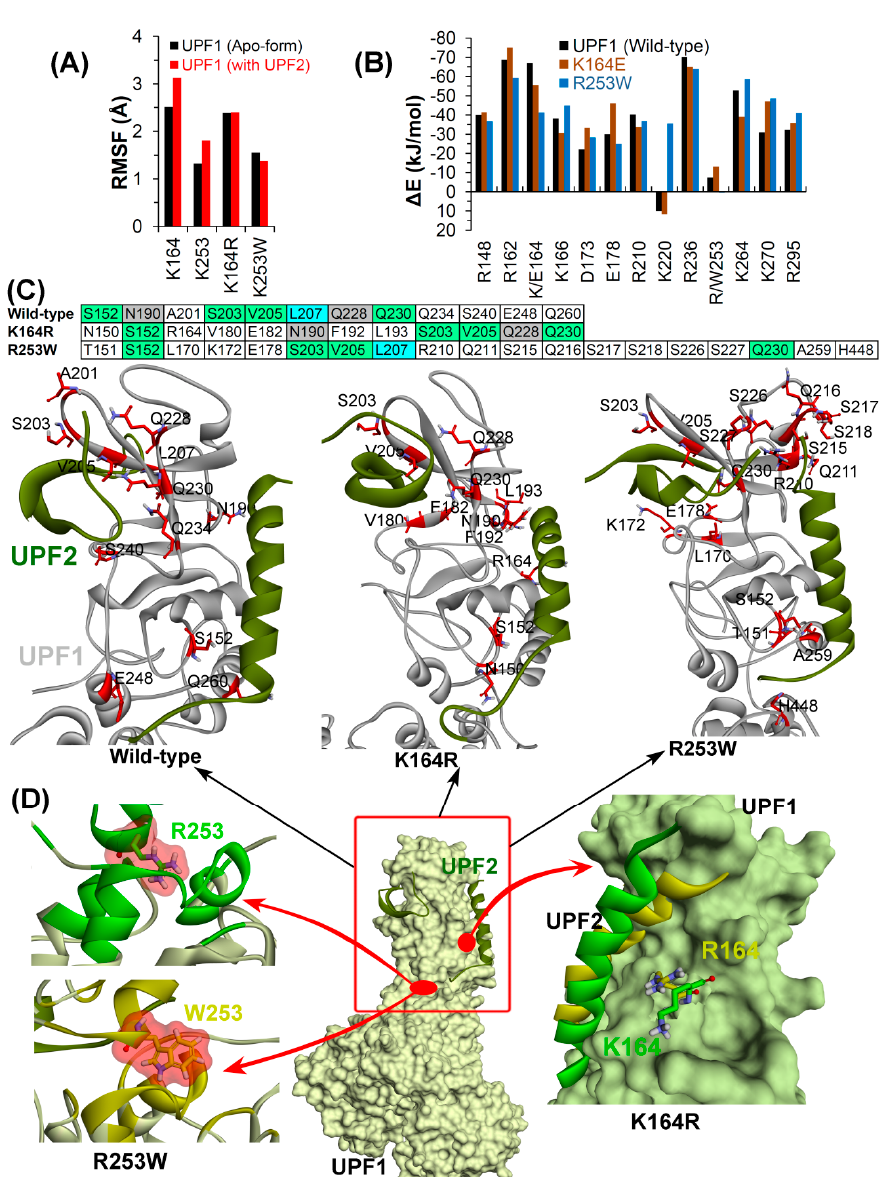
Figure 7. Detailed analysis of UPF1-UPF2 model systems. ( A ) UPF1 residues involved in binding with UPF2 and their mutations. RMSF values were calculated in native or wild-type UPF1, mutant models, apo-form, and UPF1 bound with UPF2. ( B ) Individual UPF1 residues contributing to the binding energy with UPF2, were computed using MM-PBSA. ( C ) Interactions of UPF1 with UPF2 in different model systems, and residues of UPF1 forming stable H-bonds with UPF2 having occupancy ≥ 10%. ( D ) Binding mode or conformation of the UPF1 residues (K164 and R253 in native or mutated form R164 and W253) with UPF2 (Color scheme: green represents wild-type and yellow mutated systems, carbon in green/yellow, oxygen in red, nitrogen in blue, and hydrogen in silver).